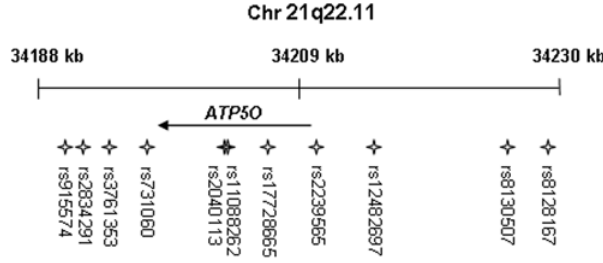
Figure 1. Chromosomal position of ATP5O and location of analyzed